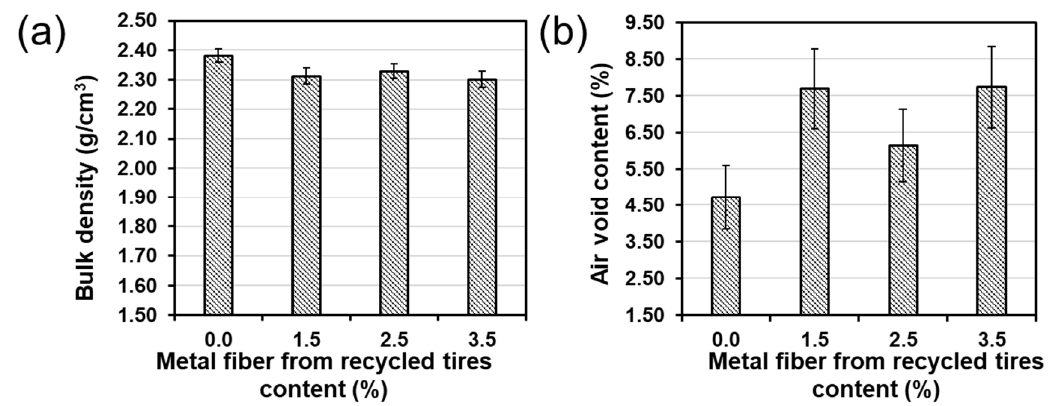
ff ect from recycled tires on the ( a ) bulk density; and ( b ) air voids Figure 4. Metal fiber effect from recycled tires on the ( a ) bulk density; and ( b ) air voids content. Figure 4. Metal fiber e